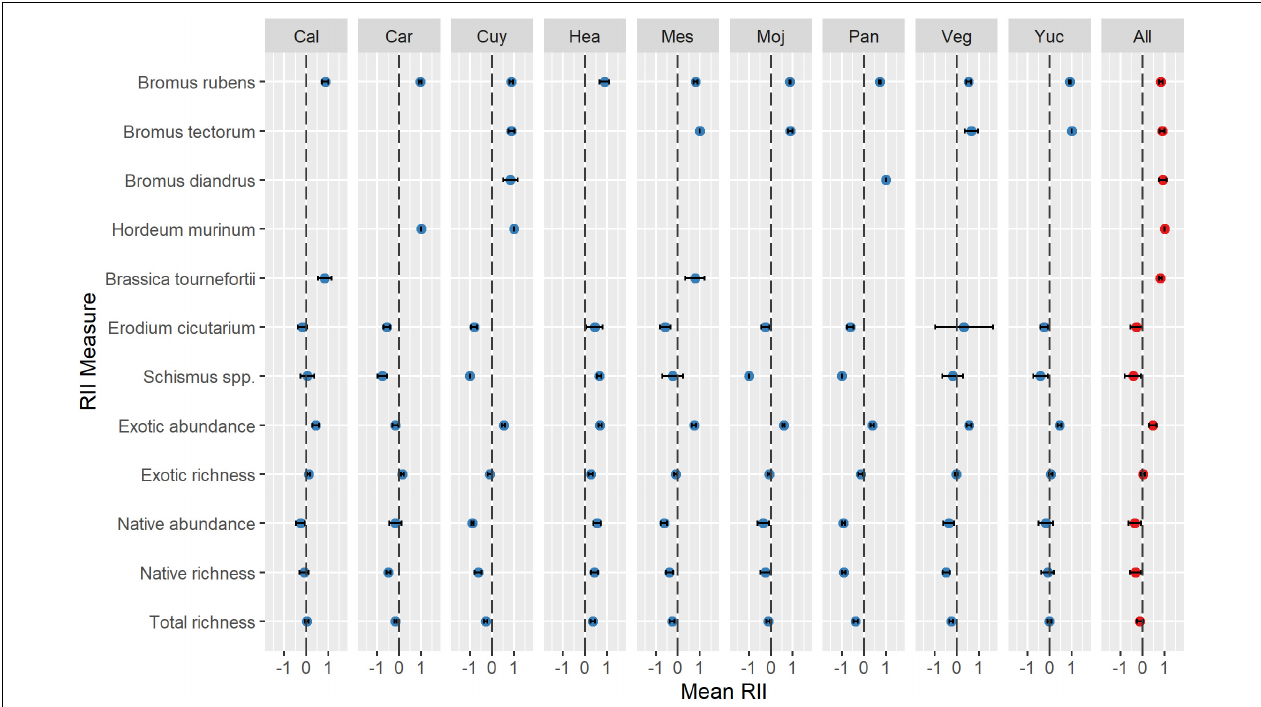
FIGURE 1 | Mean intensity (RII ± 95% CI) of shrub-herbaceous plant associations at each study site and averaged across all sites (“All”; shown in red). RIIs > 0 suggests positive (i.e., facilitative) shrub-annual associations; RIIs < 0 suggests negative (i.e., antagonistic) associations. Site names are abbreviated by their first three letters (see Supplementary Table 1 for full